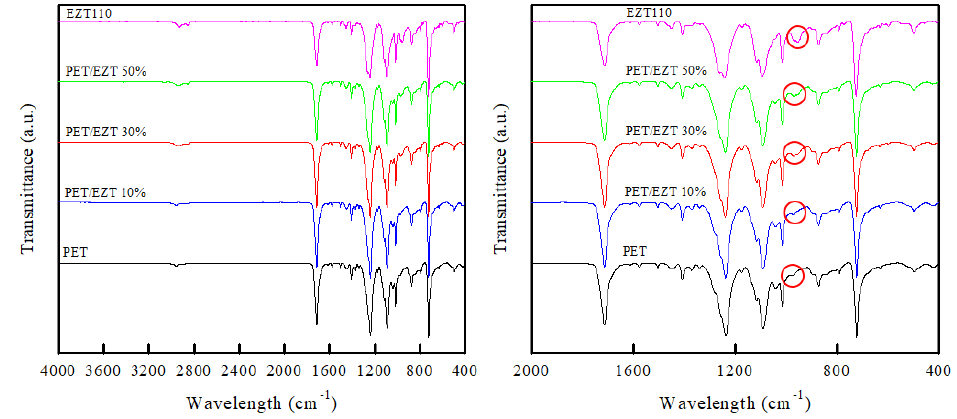
Figure 2. ATR-FTIR spectra of the polyethylene terephthalate (PET)/ECOZEN ® T110 (EZT) sam-